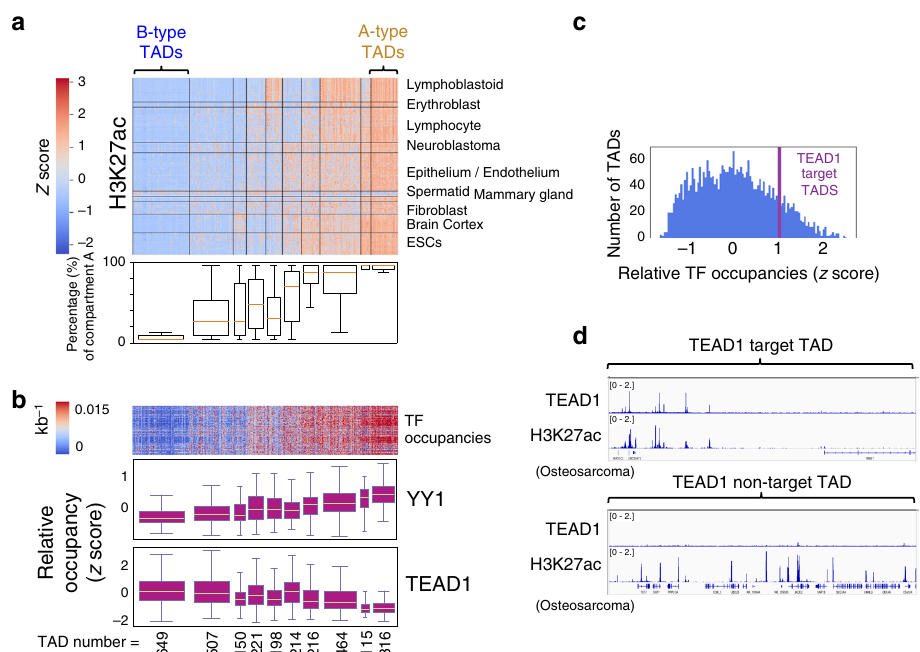
Fig. 2 Long-range TFs and short-range TFs have distinct binding pro fi les. a Top: heatmap of average H3K27ac levels in 3051 TADs across 1544 samples. Hierarchical clustering derives 10 TAD clusters and 10 sample clusters, with TAD clusters re-ordered using mean H3K27ac abundances. 316 A-type TADs and 649 B-type TADs correspond to high and low H3K27ac levels in the majority of samples. Bottom: percentage of Hi-C derived compartment A in TAD clusters. The box plot extends from the lower to the upper quartile values of the data, with a line at the median. The whiskers extend from the box to show the range of the data. b Top: ChIP-seq peak numbers per kb in TADs across 1396 samples. For each TF ChIP-seq sample only the most signi fi cant 20,000 peaks are used, and the TADs are ordered as in Fig. 2a. Bottom: the relative occupancies ( z scores) of YY1 and TEAD1 in TAD clusters. The relative occupancy of TF i in a given TAD is the binding density of the TF in that TAD relative to the binding densities of other TFs in the same TAD. The box plot illustrates data as a . c TEAD1 target TADs are de fi ned as those TADs with a TEAD1 occupancy ≥ 1 standard deviation among all TFs ( z scores ≥ 1). d In SF269 cell, TEAD1 ChIP-seq peaks and H3K27ac signals colocalize well in a TEAD1 target TAD, but not in a non-target one. Source data are provided as a Source Data fi